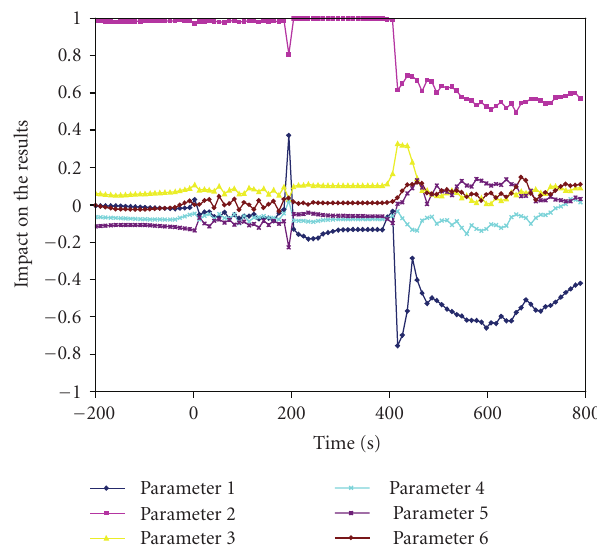
Figure 16: Three MCPs sequential trip. The impact of parameters No.1–No.6 on the coolant flow rate through the a ff ected MCC loop. The numbering of parameters is the same as in Table 2.